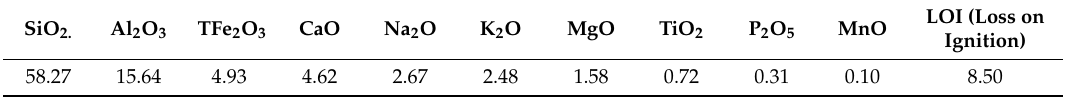
Table 3. Chemical composition of oil shale residue.